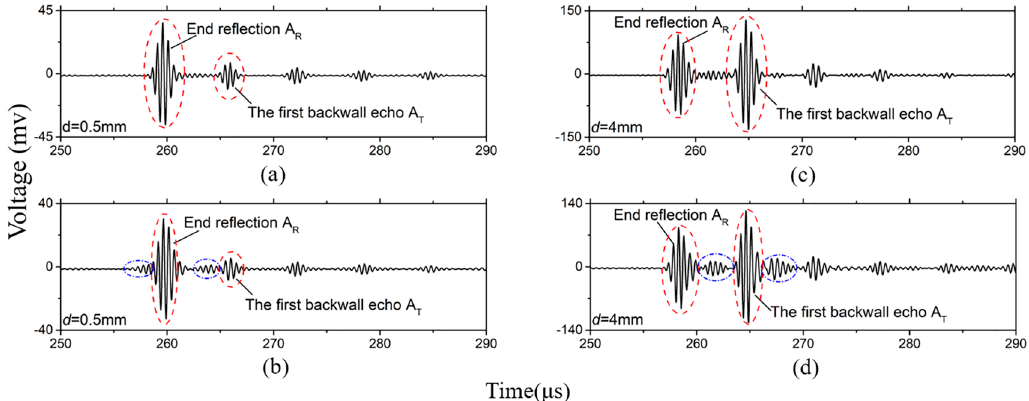
Figure 8. Waveforms of the time domain in some waveguide bars: ( a ) d = 0.5 mm, w = 13 mm, the loading is anti-plane shear source; ( b ) d = 0.5 mm, w = 13 mm, the loading isn’t anti-plane shear source; ( c ) d = 4 mm; w = 13 mm; the loading is anti-plane shear source ( d ) d = 4 mm, w = 13 mm, the loading isn’t anti-plane shear source.